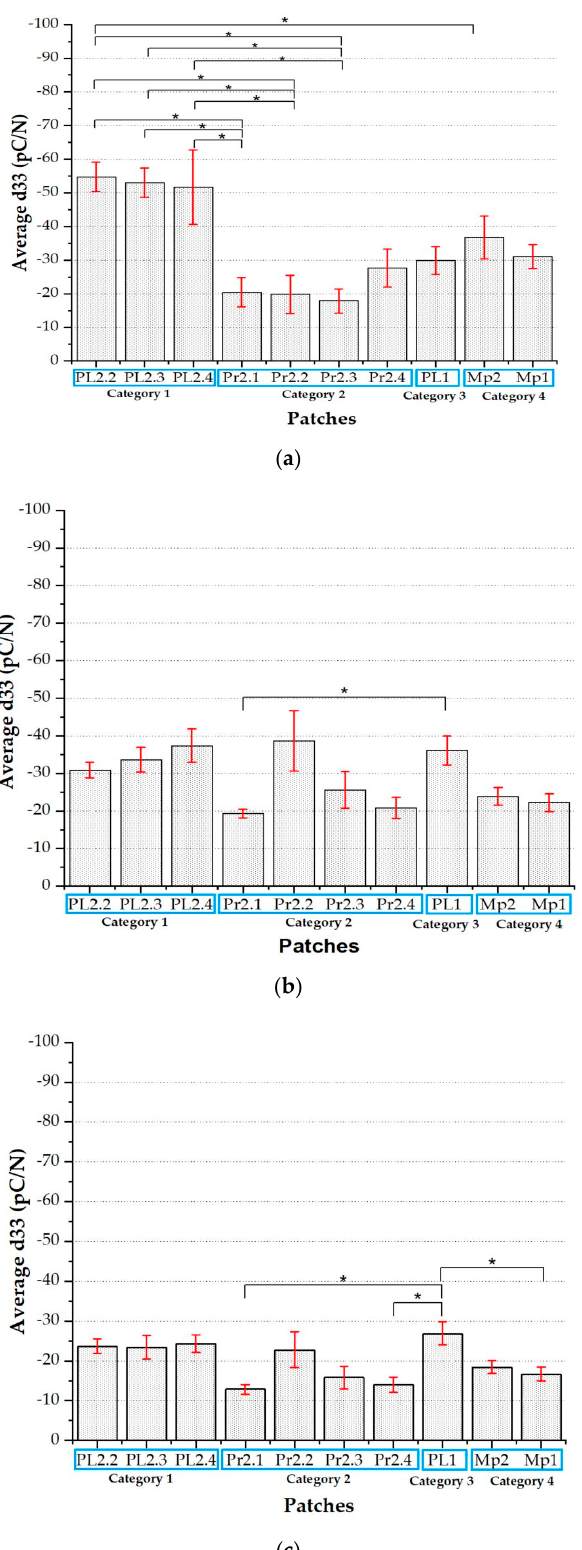
Figure 14. Average d 33 vs. patches at PL = 1 N, 2 N, and 3 N, arranged respectively as ( a ), ( b ) and ( c ). The four categories and all corresponding patches can be distinguished on the x